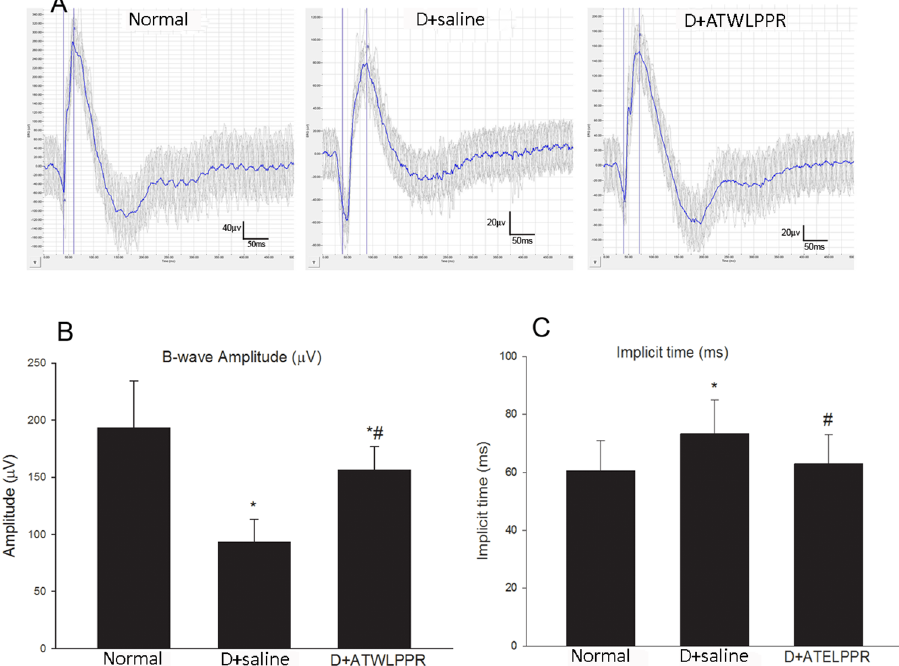
Fig 2. ERG responses in the Normal, D+saline and D+ATWLPPR groups. (A) Representative original recordings from the three groups; (B) Quantitative analysis of b-wave amplitudes (mV); (C) Quantitative analysis of b-wave implicit time (ms). * P < 0.05 versus the Normal group; # P < 0.05 versus the D+saline group. D,